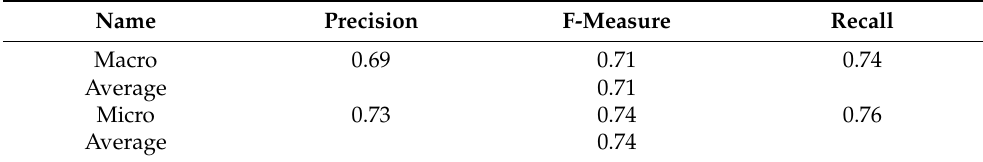
Table 9. The average performance of testing data of the Alex net